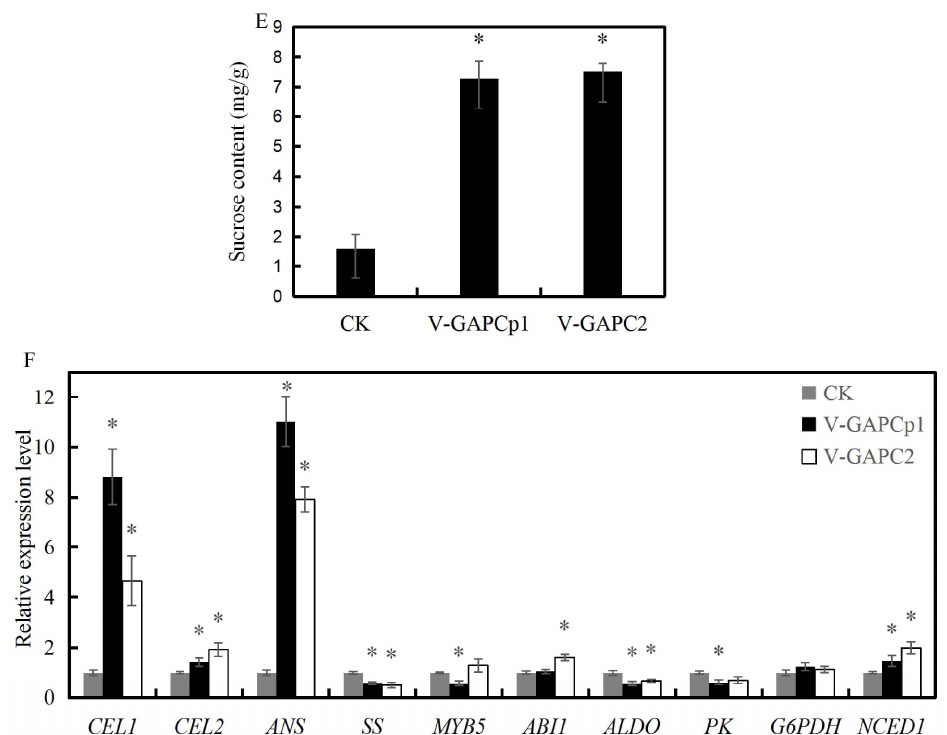
Figure 5. VIGS (virus induced gene silencing) for the FaGAPC2 and FaGAPCp1 genes in strawberry fruits. ( A ) Transcript levels of FaGAPCp1 in the control, FaGAPCp1 -RNAi fruit by qRT-PCR; ( B ) transcript levels of FaGAPC2 in the control, FaGAPC2 -RNAi fruit by qRT-PCR; ( C ) the total anthocyanins content in the control, FaGAPC2 -RNAi, and FaGAPCp1 -RNAi fruit; ( D ) the ABA content in the control, FaGAPC2 -RNAi, and FaGAPCp1 -RNAi fruit; ( E ) the sucrose content in the control, FaGAPC2 -RNAi, and FaGAPCp1 -RNAi fruit; ( F ) transcript levels of ripening-related genes in the RNAi fruits and control. CK: control fruit; V-GAPCp1: FaGAPCp1 -RNAi fruit; V-GAPC2: FaGAPC2 -RNAi fruit. Data are means ( ± SD) obtained from three biological replicates. Asterisks indicate statistically significant di ff erences at p ≤ 0.05 as determined by Student’s t